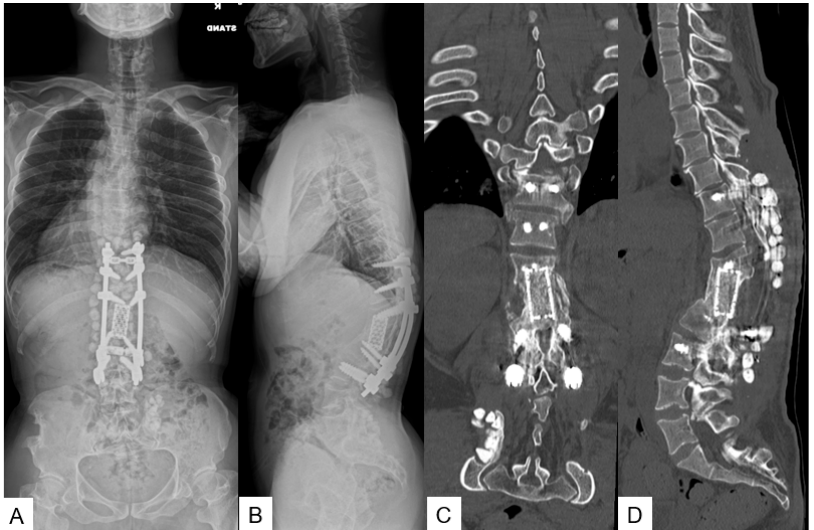
Figure 12. A 26-year-old man with achondroplasia; final follow-up images. ( A , B ) Follow-up radio- grams show T11-L2 local 58° kyphosis, SVA 32 mm, PT 23°, and PI 82°; ( C , D ) follow-up reconstruc- tion CT shows solid bony fusion.